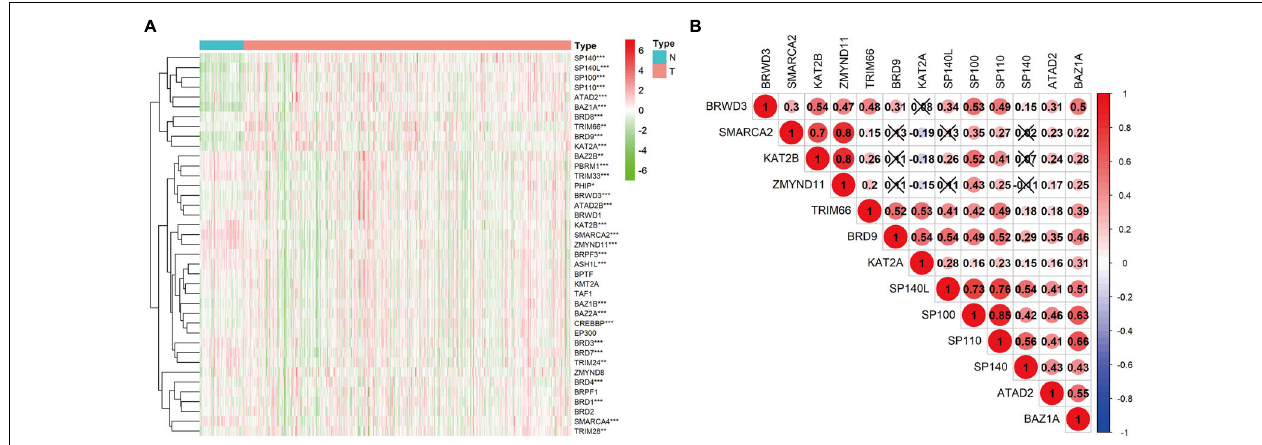
FIGURE 1 | Heatmap and correlation matrix of BRD genes. (A) mRNA levels of 42 BRD genes in KIRC. * P < 0.05; ** P < 0.01; *** P < 0.001; N, normal control; T, tumor samples; the gene upregulated in red; the gene downregulated in green. (B) Correlation between differentially expressed BRD genes.